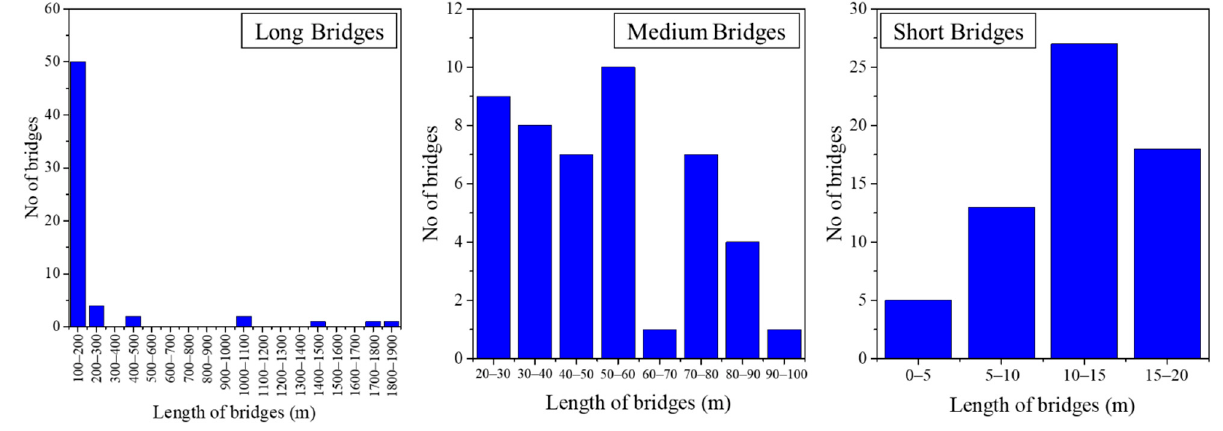
Figure 12. A histogram of the length of bridges in each category.